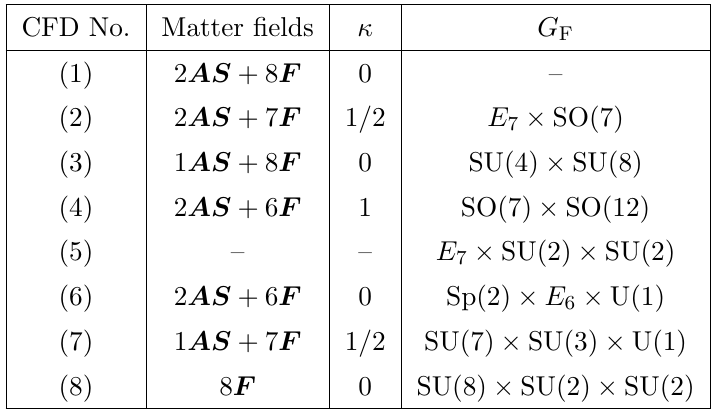
Table 3. The SU(4) (cid:20) gauge theory description and superconformal (cid:13)avor symmetry G F of the descendant theories from the ( E 7 ; SO(7)) marginal CFD. The CFD numbering corresponds to that in (cid:12)gure 24. Model (5) does not have a description in terms of an SU(4) gauge theory, but it has a 6 F (cid:0) Sp(2) (cid:0) Sp(1) quiver gauge theory description